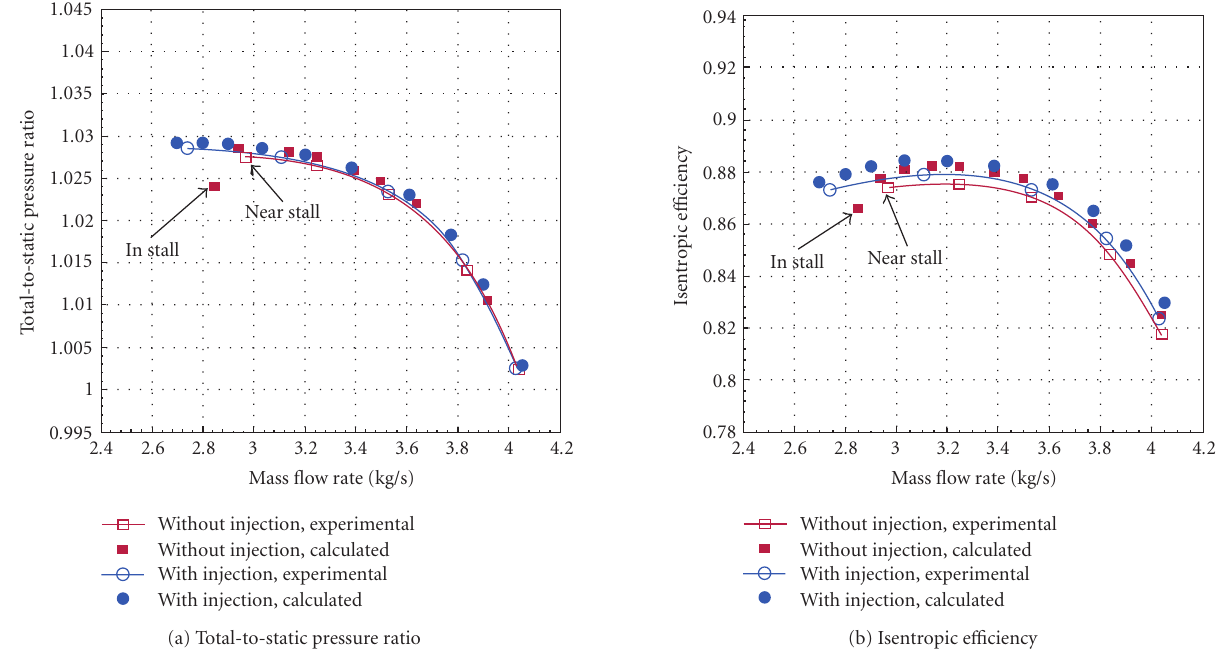
Figure 7: Tested and computed compressor map for 71% design speed.